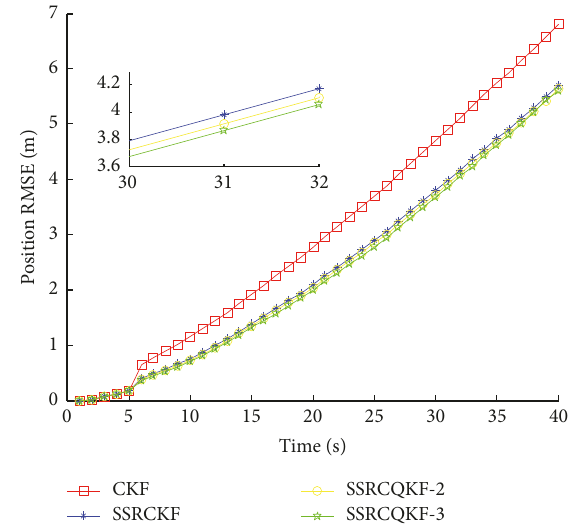
Figure 4: The position RMSE of various filters.